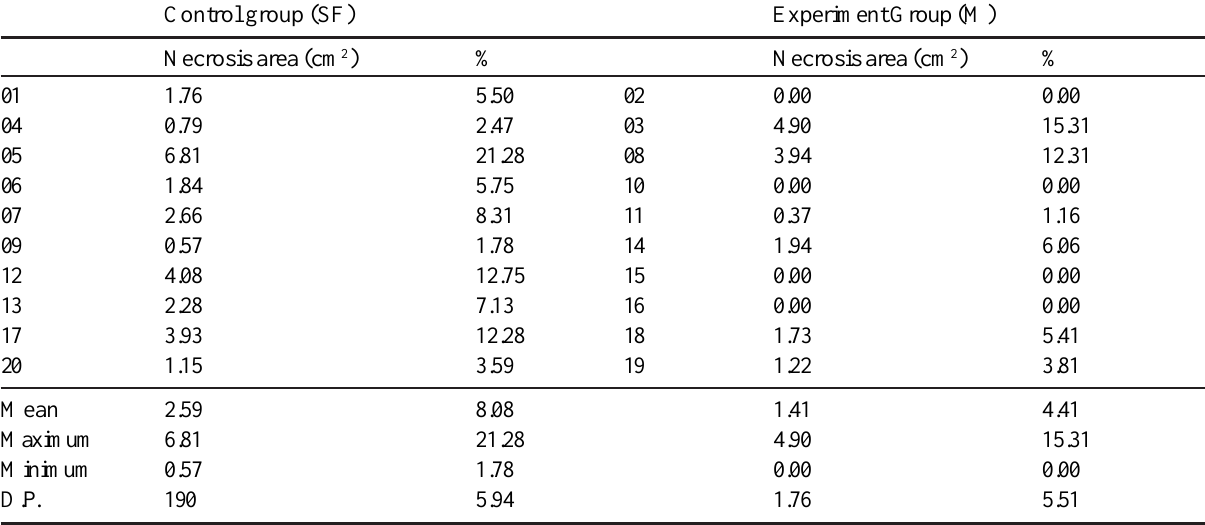
TABLE 2 - Necrosis area on the seventh postoperative day.